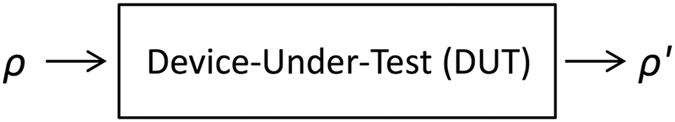
The input state ρ changes to ρ′ upon traversal through a device-under-test (DUT).